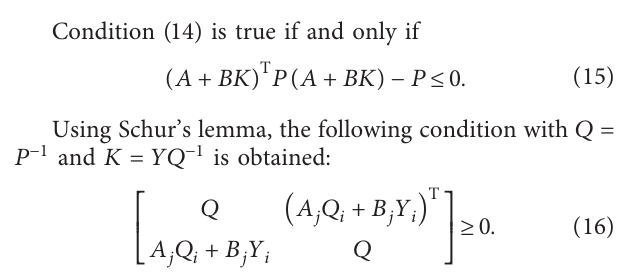
Figure 1: Flowchart of the proposed